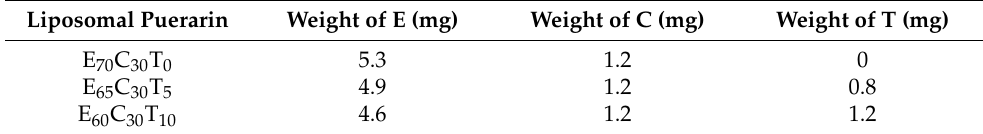
Table 1. The compositions for the preparation of